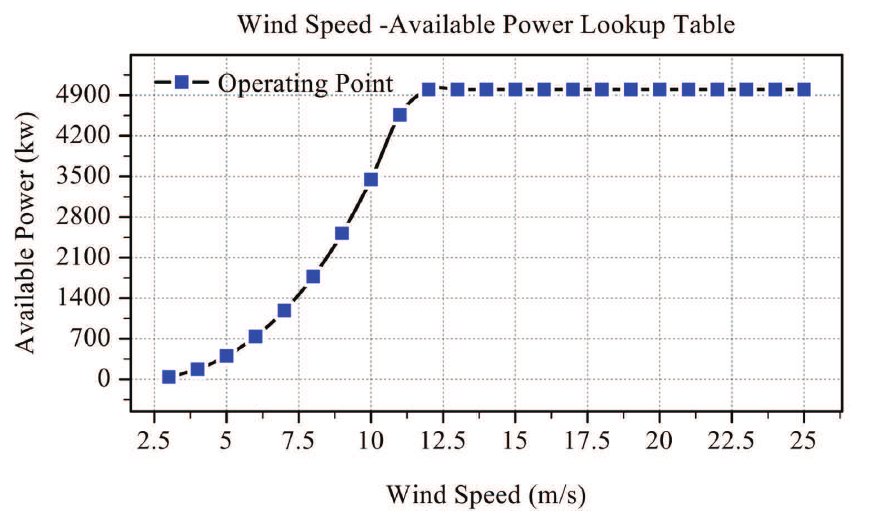
Figure 1. Wind speed—available power lookup